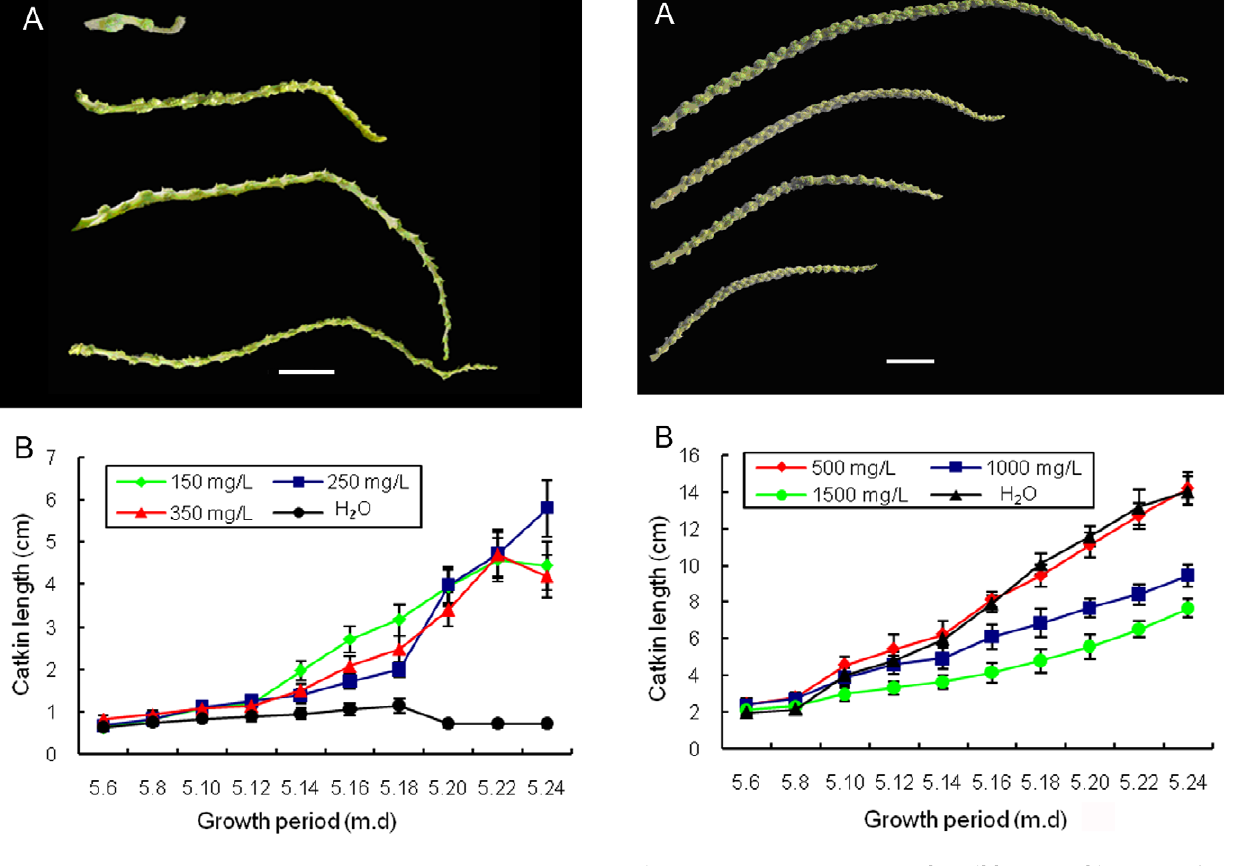
Figure 4. Exogenous GA 3 treatment on the sck1 catkins. ( A ) The sck1 catkins from up to down were treatment by H 2 O, 150 mg/L, 250 mg/L and 350 mg/L of GA 3 on mutant catkins every two days during growth period in year 2007 and length changes were recorded. Bar =1 cm. ( B ) The average length of sck1 catkins after different concentrations of GA 3 treatment. Data are means ( 6 SE, n=30).